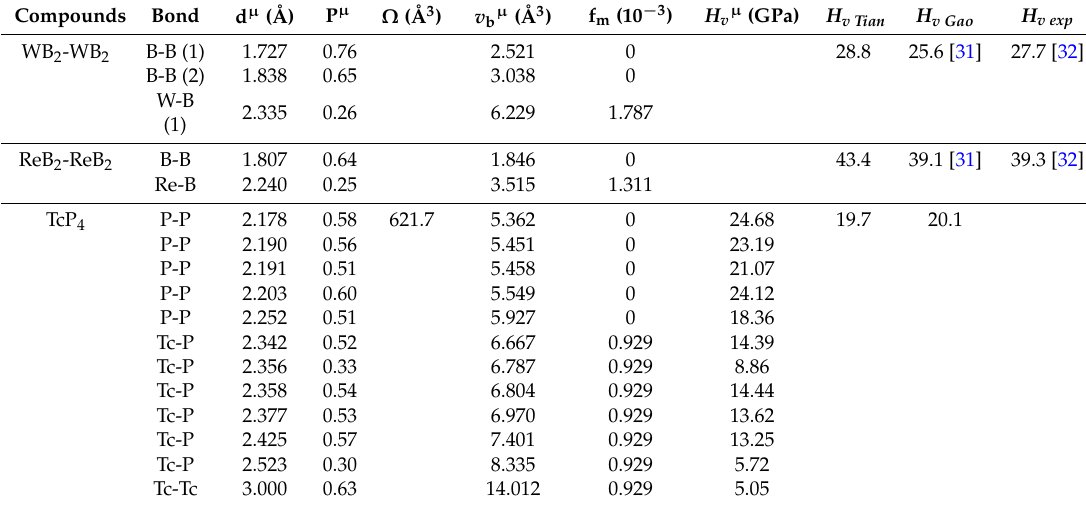
Table 2. Calculated bond parameters and theoretical hardness obtained by the models of Tian et al. and Gao et al. at ambient pressure. Experimental data are presented for comparison.